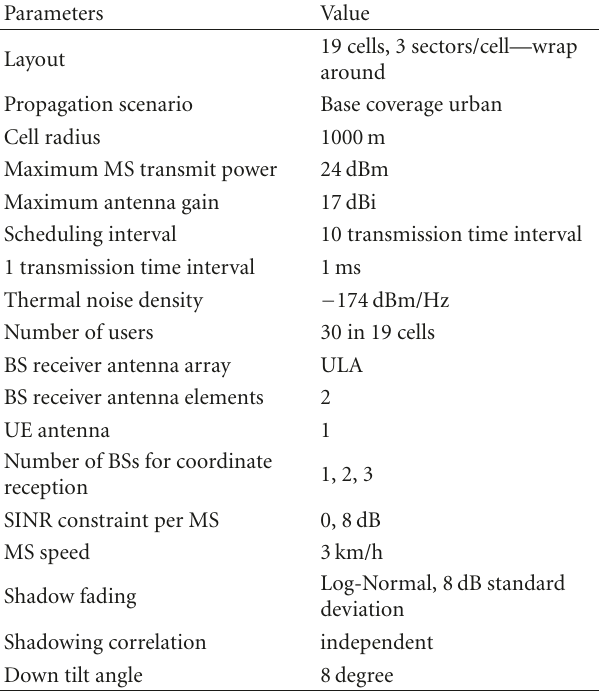
Table 1: Simulation